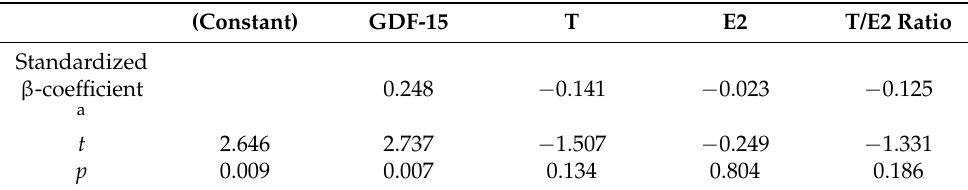
Table 3. Multivariate linear regression to identify associations of sex hormone and GDF-15 levels with HAMD-24 scores in MDD patients.